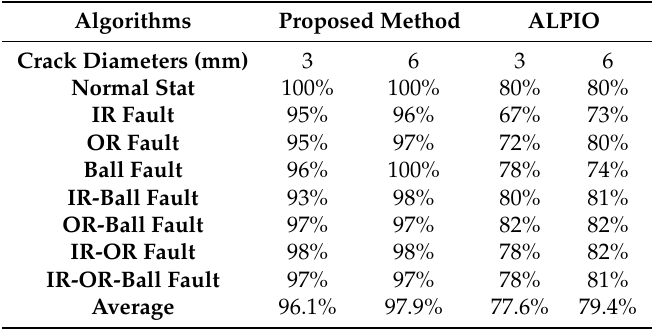
Figure 19. Residual signal for the inner-outer-ball faulty condition, normal, ball, inner, outer, inner-ball, outer-ball, and inner-outer thresholds with a crack width of 6 mm.